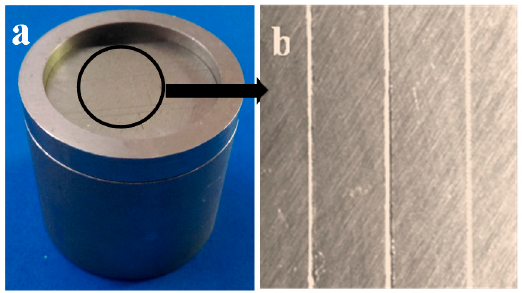
Figure 4. ( a ) Stainless steel die used for detail reproduction assessment, ( b ) Stereomicroscopic images for the three scribed parallel lines.